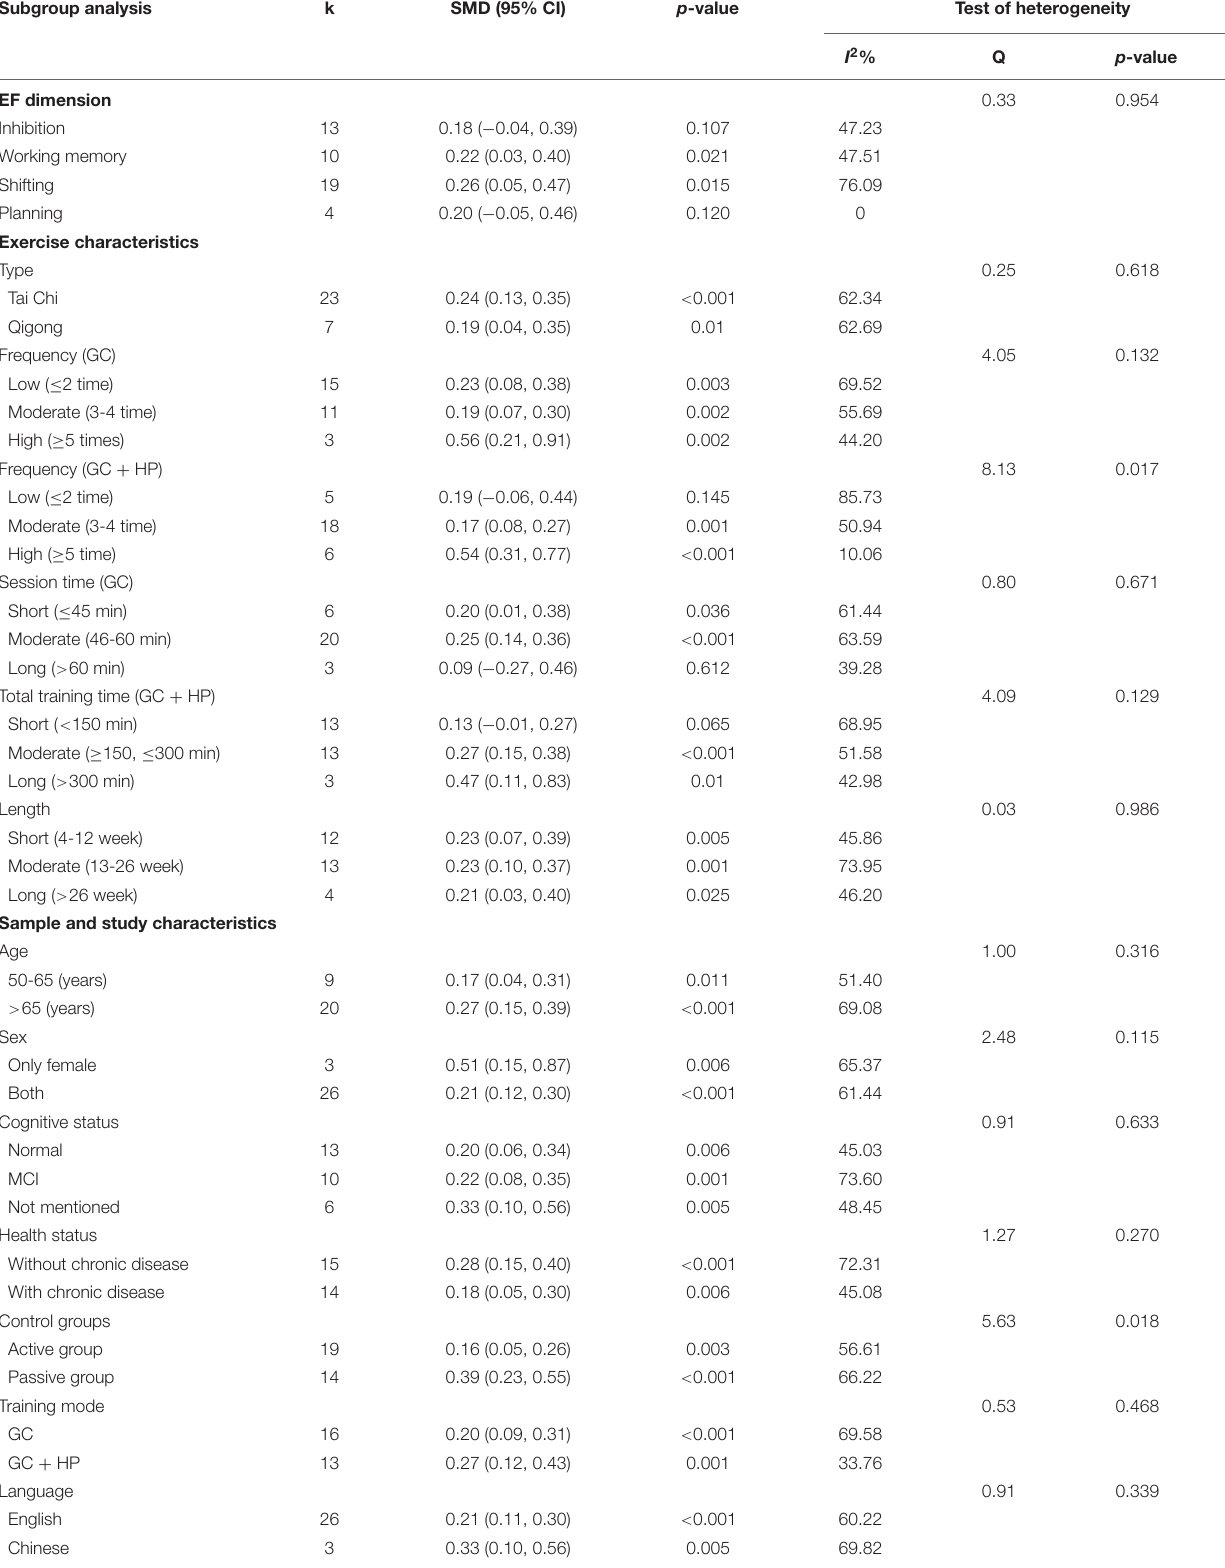
TABLE 4 | Analysis and subgroup analysis results regarding the effects of Chinese mind-body exercises on executive function. Subgroup